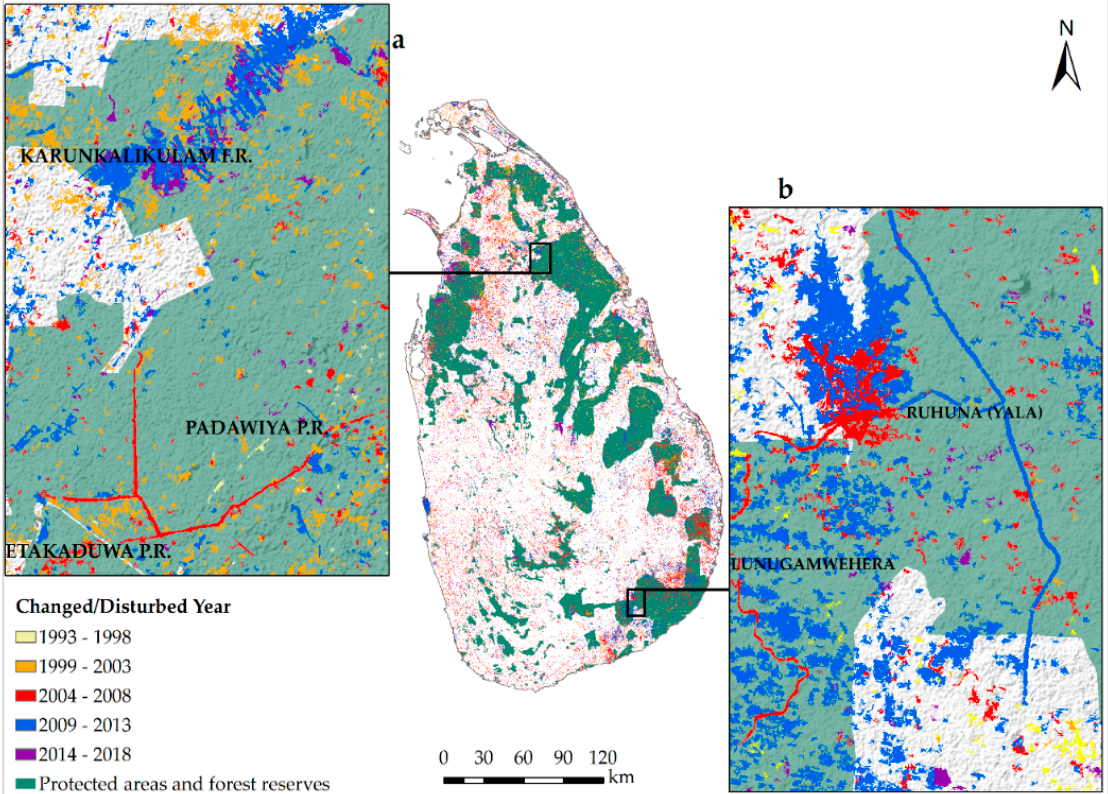
Figure 9. Two specific case studies of land cover change in protected areas: ( a ) Land cover change in Karunkalikulam and Padaviya: forest cleared for road construction during and after the war 2008–2018. ( b ) Deforestation followed by the construction of a reservoir and a road in 2008–2013 in Lunugamwehera National Park and Ruhuna (Yala) National